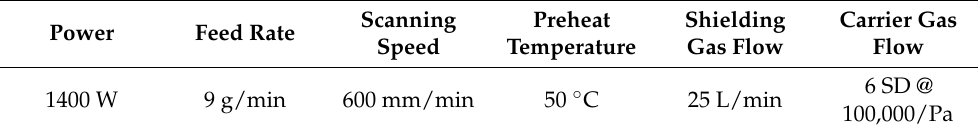
Table 1. Chemical composition of 316L steel and Colmonoy-6 materials.